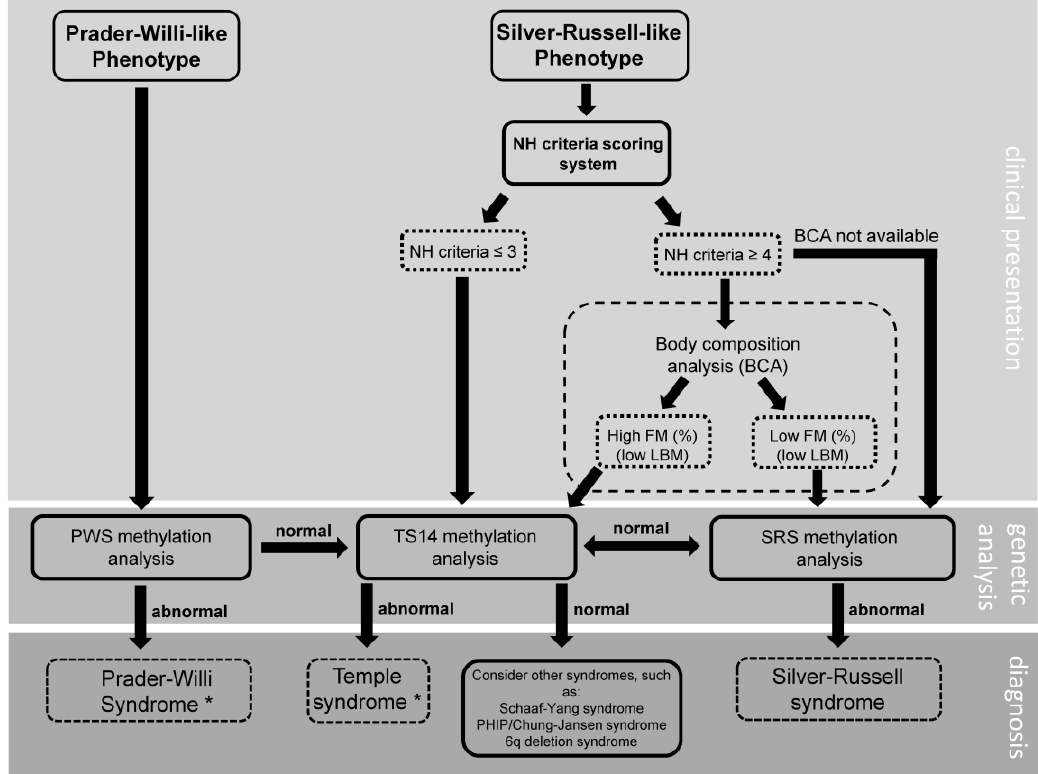
Figure 1. Clinical diagnostic flowchart for patients with a Prader – Willi-like or Silver – Russell-like phenotype. NH: Netchine – Harbison; FM: fat mass, LBM: lean body mass, PWS: Prader – Willi syndrome; TS14: Temple syndrome; SRS: Silver – Russell syndrome; BCA: body composition analysis. * after establishment of diagnosis, further testing to identify the genetic subtype should follow.